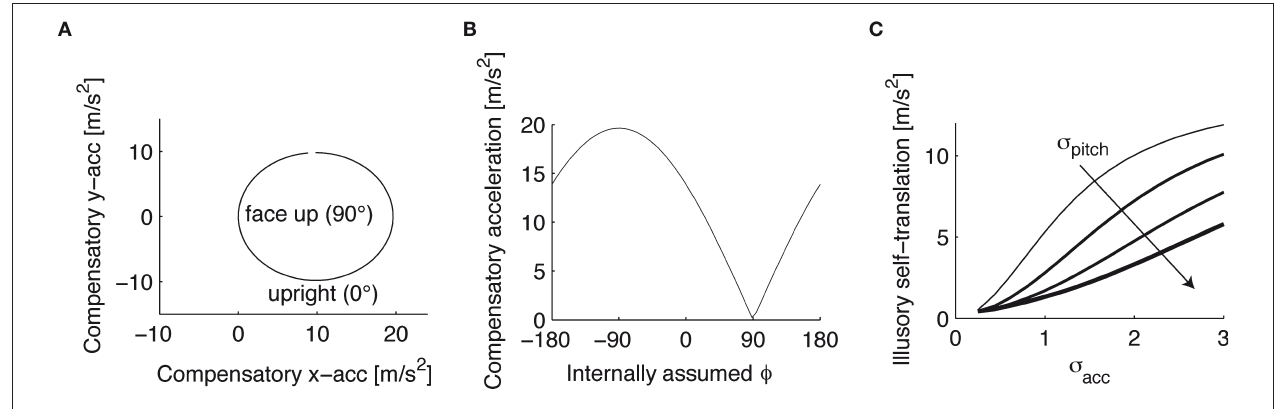
FIGURE 3 | Compensatory acceleration to account for the mismatch between the supine and upright position. (A) Compensatory acceleration in the xy-plane to account for the sensory signals in a stationary supine position in terms of accelerations in the upright position. (B) Magnitude of the